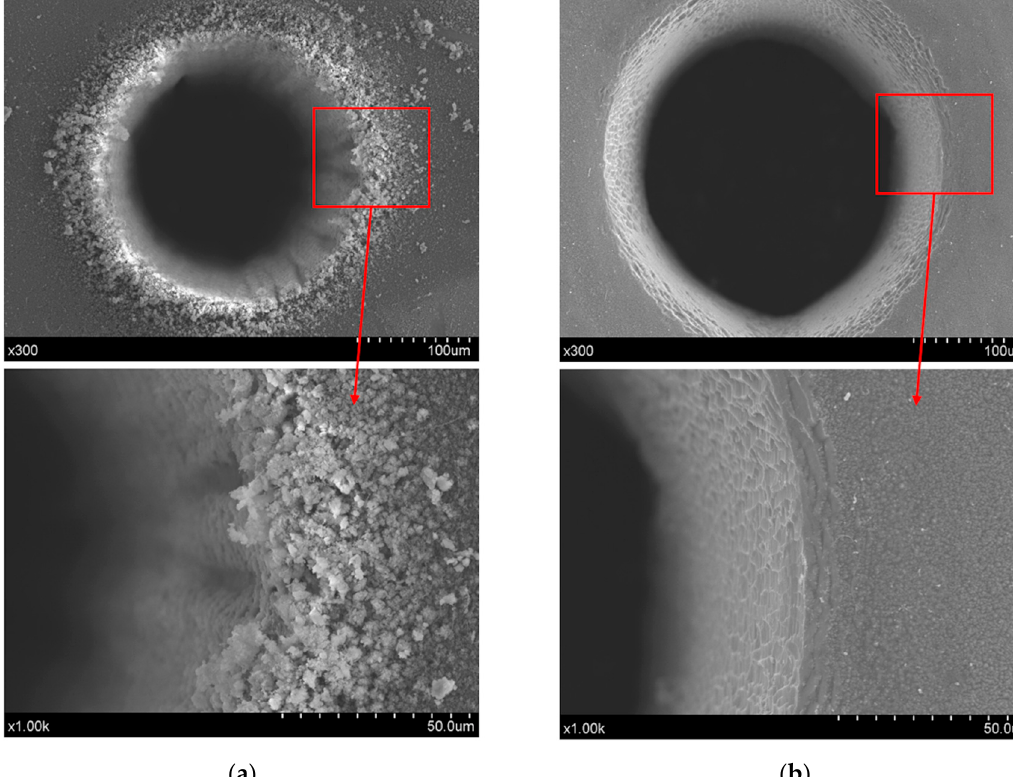
Figure 4. Entrance comparison of the micro-trepanning results, in which ( a ) corresponds to direct laser machining, while ( b ) represents the chemical-assisted method. The processing parameters include: P = 18.5 W, f = 0.4 MHz, v = 600 mm/s, n = 20, m = 120, and an NaOH solution with a concentration of one mol/L was employed in the chemical-assisted laser processing.